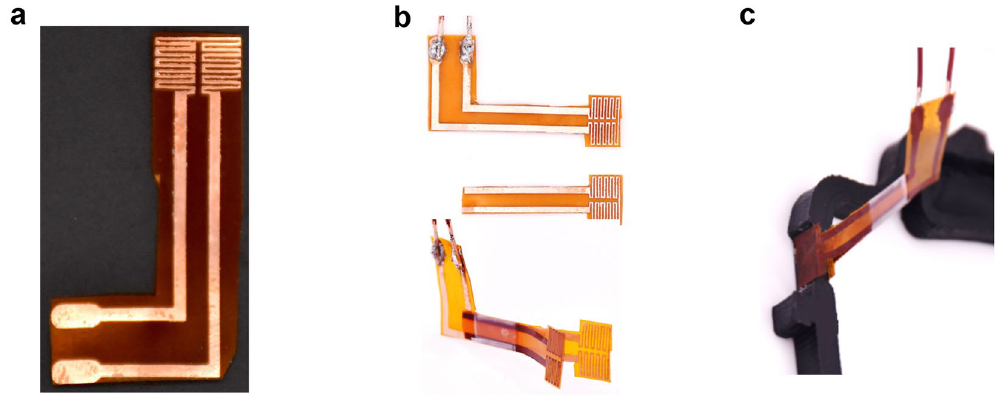
Figure 3. Heating circuit. ( a ) Single sided heating unit. ( b ) Double sided heating unit. ( c ) Double sided heating unit on the visor frame.